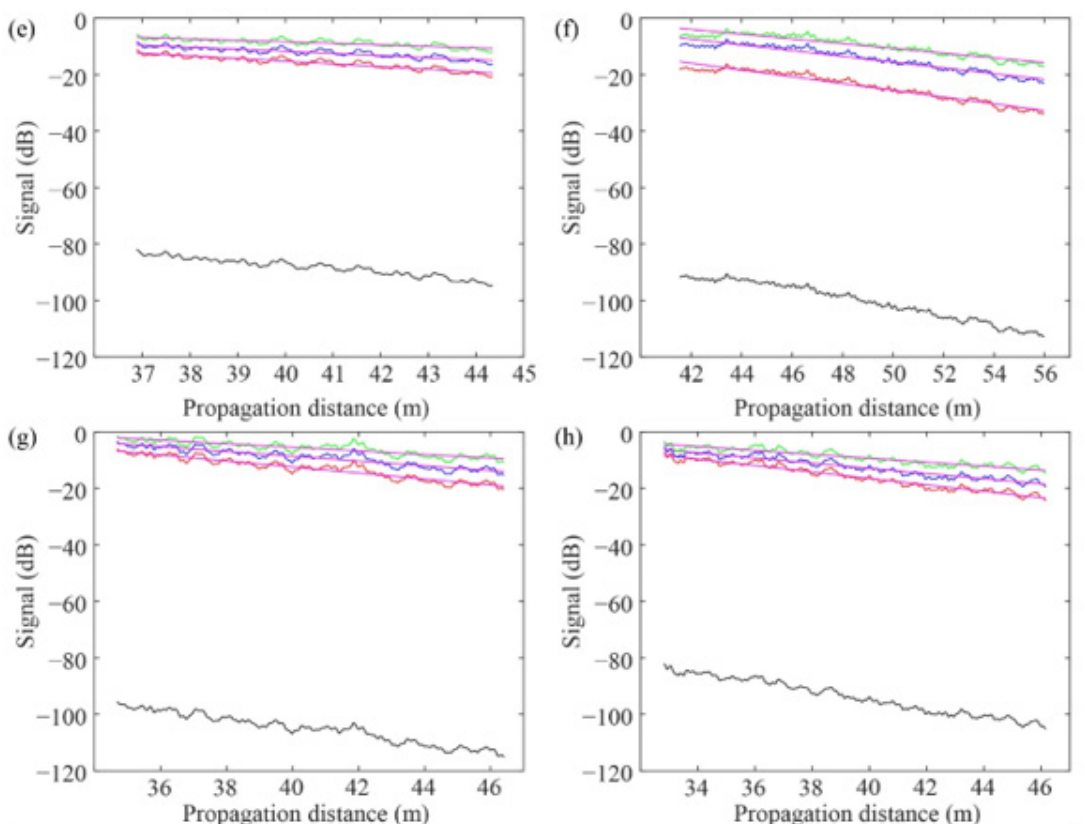
Figure 7. The estimated result of signal attenuation of LPR. ε = 3.5 is used for time-to-propagation distance conversion. ( a – h ) present the attenuation estimated result of correspond to the eight calculation regions in Figure 6, respectively. Table 2. The loss tangent’s estimated